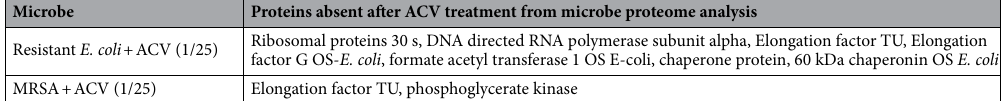
Microbe Proteins absent after ACV treatment from microbe proteome analysis Resistant E. coli + ACV